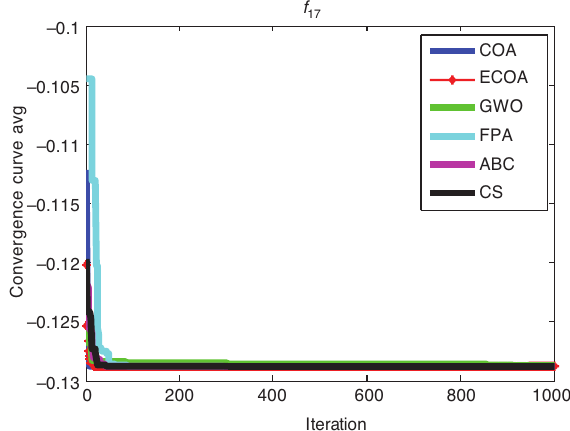
Figure 33: D = 3, Evolution Curves of Fitness Value for f